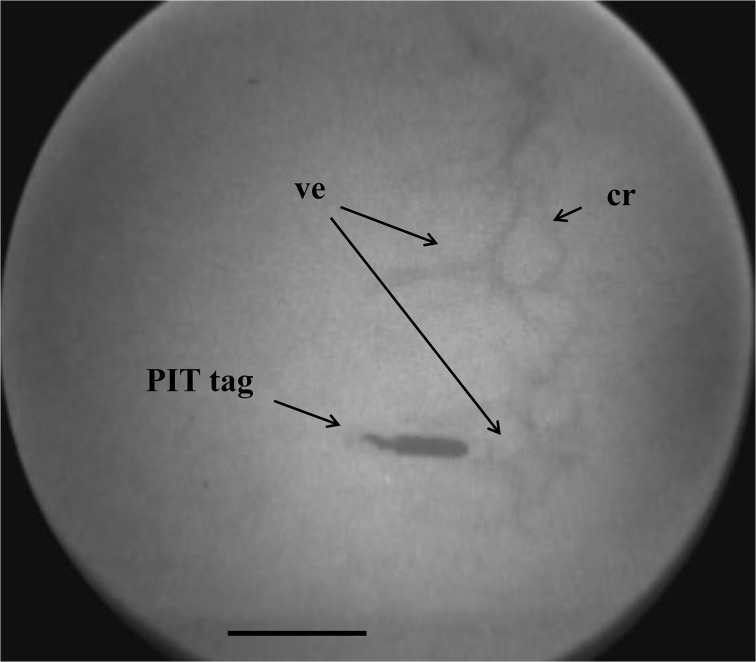
X-ray photograph of sea cucumber tagged in the aquapharyngeal bulb.PIT tags successfully implanted in the aquapharyngeal bulb through a deployed tentacle lodged themselves in one of the tentacle vesicles (ve) close to the calcareous ring (cr). Scale bars represent 2 cm.